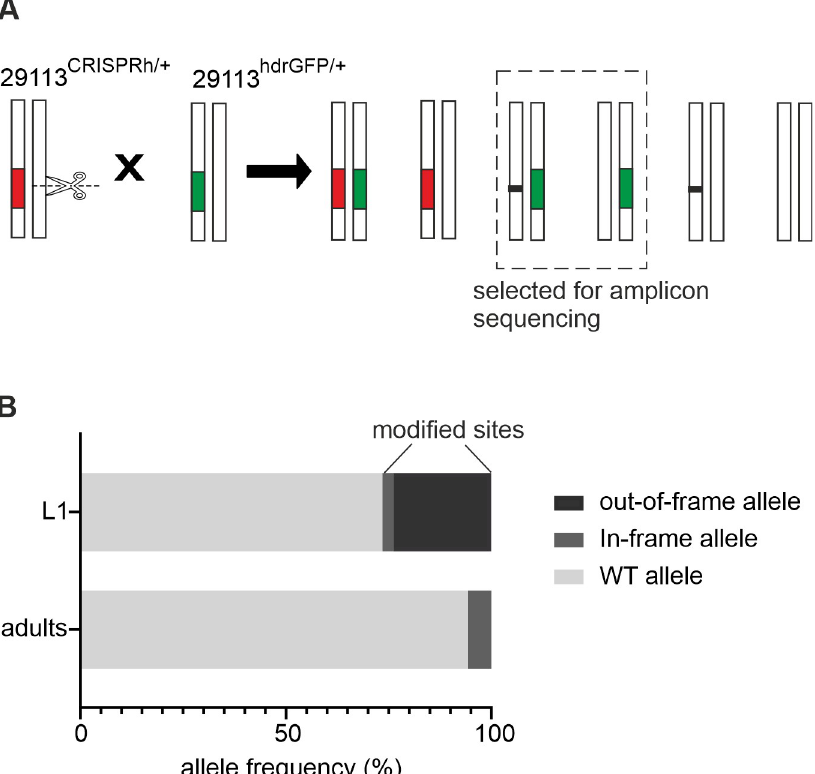
Fig 5. Resistance analysis of an ultra-conserved target site in AGAP0029113 . (A) Crossing scheme devised to allow analysis of alleles that were exposed to CRISPR/Cas9, but which were not converted to the 29113 CRISPRh construct. The crossing of heterozygous 29113 CRISPRh/+ individuals to 29113 hdrGFP/+ individuals, and subsequent screening of the offspring for GFP+, provided mosquitoes that had an 29113 hdrGFP/+ genotype, with the other allele being wild-type or containing indels generated by NHEJ repair. Red represents the 29113 CRISPRh allele (RFP+), whilst green shows the 29113 hdrGFP allele (GFP+) and black shows novel mutations. Progeny was screened for GFP+/RFP- (dashed rectangle). (B) Allele frequency (%) at the CRISPR/Cas9 cleavage site. L1: 7000 larvae, adults: 90